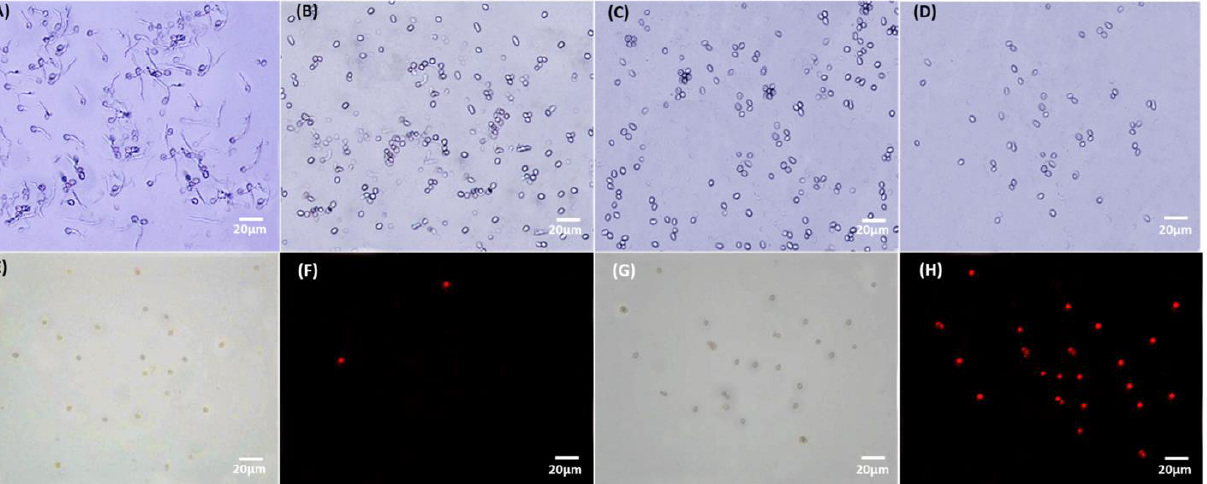
Figure 3. Effect of CH@CuO NPs concentrations on B. cinerea conidial cells treated with sterile wa- ter (control) ( A ), ( B – D ) incubated in CH@CuO NPs at 50, 100 and 250 mg/L for 8 h, respectively; ( E ) conidial cells of B. cinerea incubated in sterile water for 8 h and stained by propidium iodide (con- trol) ( F – H ) conidia cells of B. cinerea stained by propidium iodide after treatment for 8 h with CH@CuO NPs at 50, 100 and 250 mg/L, respectively. ( I ) Germ tube length of B. cinerea in response to treatment with CH@CuO NPs at concentrations 50, 100 and 250 mg/L compared to control.